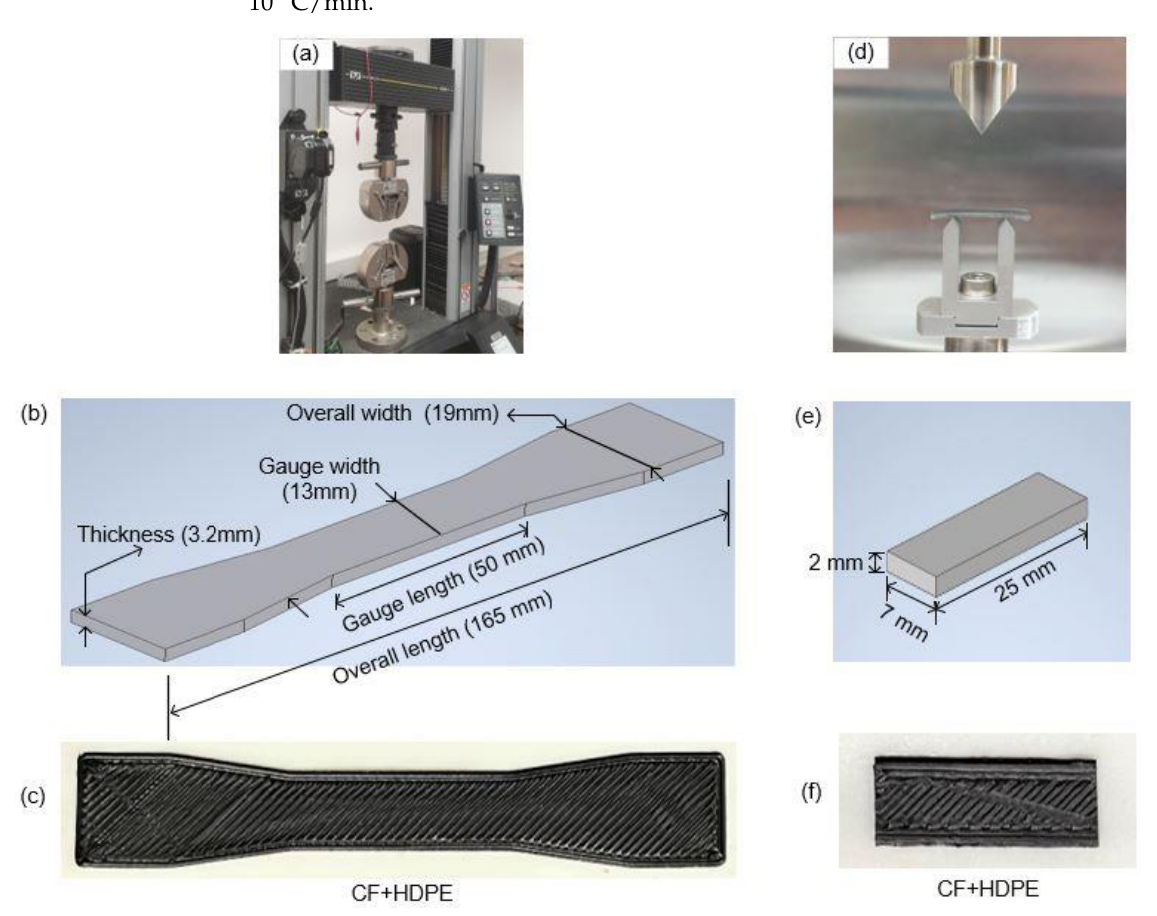
Figure 3. Experimental setup and specimens used to test mechanical properties: ( a ) a tensile test machine, ( b ) a schematic of a dog-bone part with dimensions for tensile tests, ( c ) a fabricated dog- bone part, ( d ) a DMA test machine, ( e ) a schematic of a rectangular part for DMA test, and ( f ) a fabricated part for DMA.